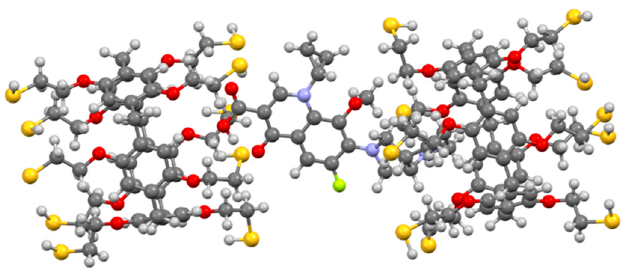
Figure 2. Geometry optimized structure of the 3 /moxi complex.